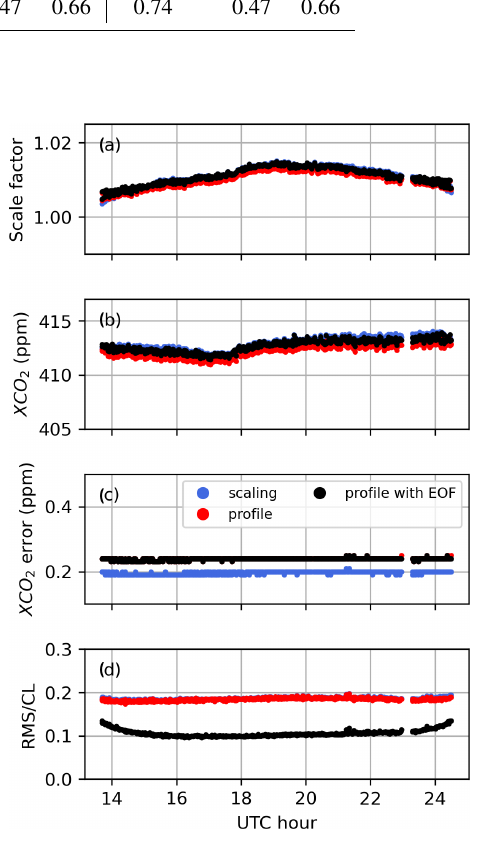
Figure E3. Same as Fig. E2 but for the TCCON1 window. Table E2. Squared Pearson correlation coefficient for XCO 2 be- tween the scaling and profile retrievals (SCL–PRF), and between the profile retrieval with the first EOF and the profile retrieval